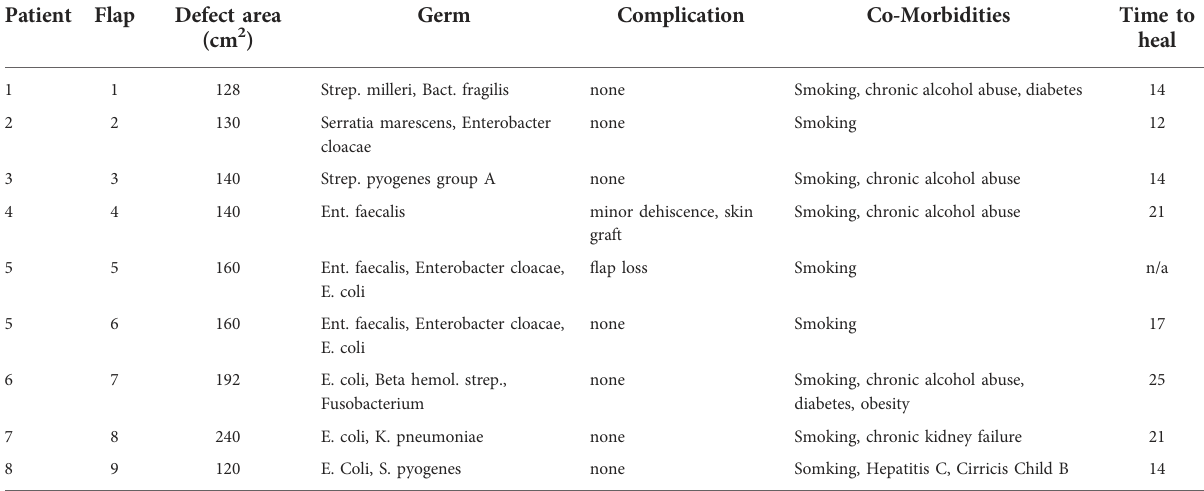
TABLE 2 Patient data. Patient Flap Defect area